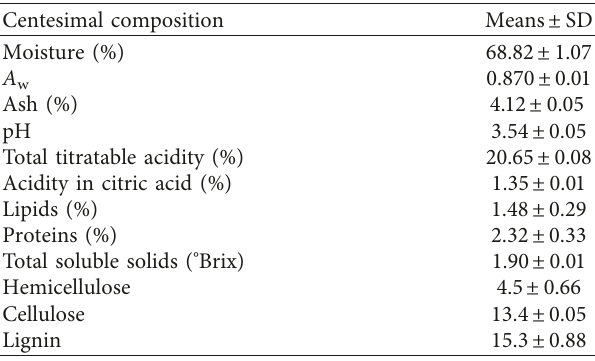
Table 2: Centesimal composition of Shiraz grape